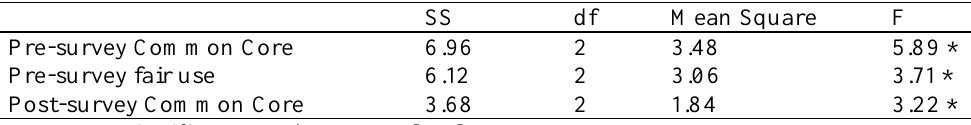
Main Effect of Time Teaching on Knowledge Items